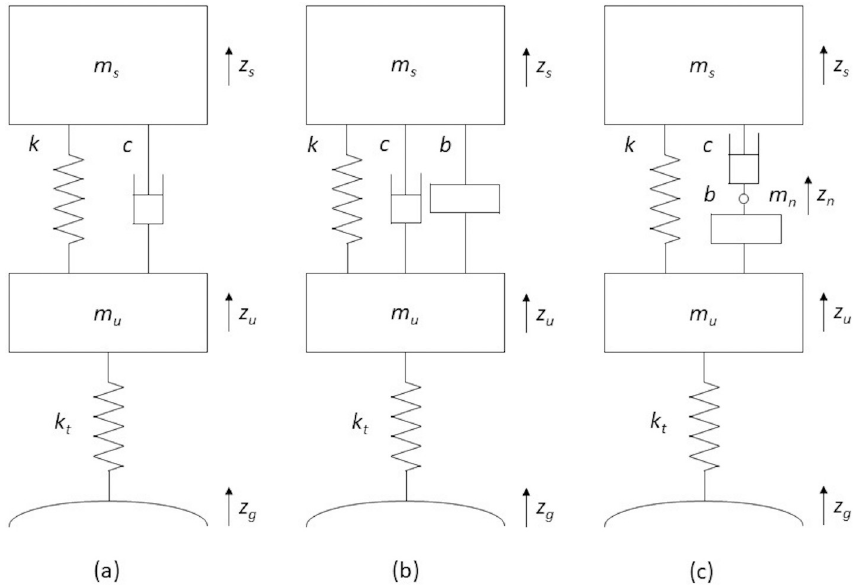
Fig 1. A quarter vehicle model with (a) typical spring and damper suspension, (b) parallel inerter suspension layout, and (c) serial inerter suspension layout.